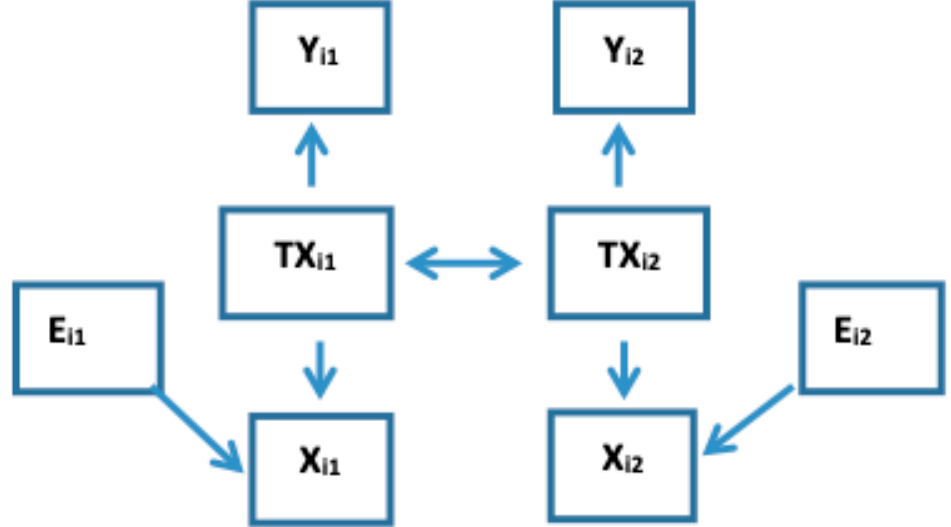
Figure 3. Illustration of residual association with independent measure error in X for K =